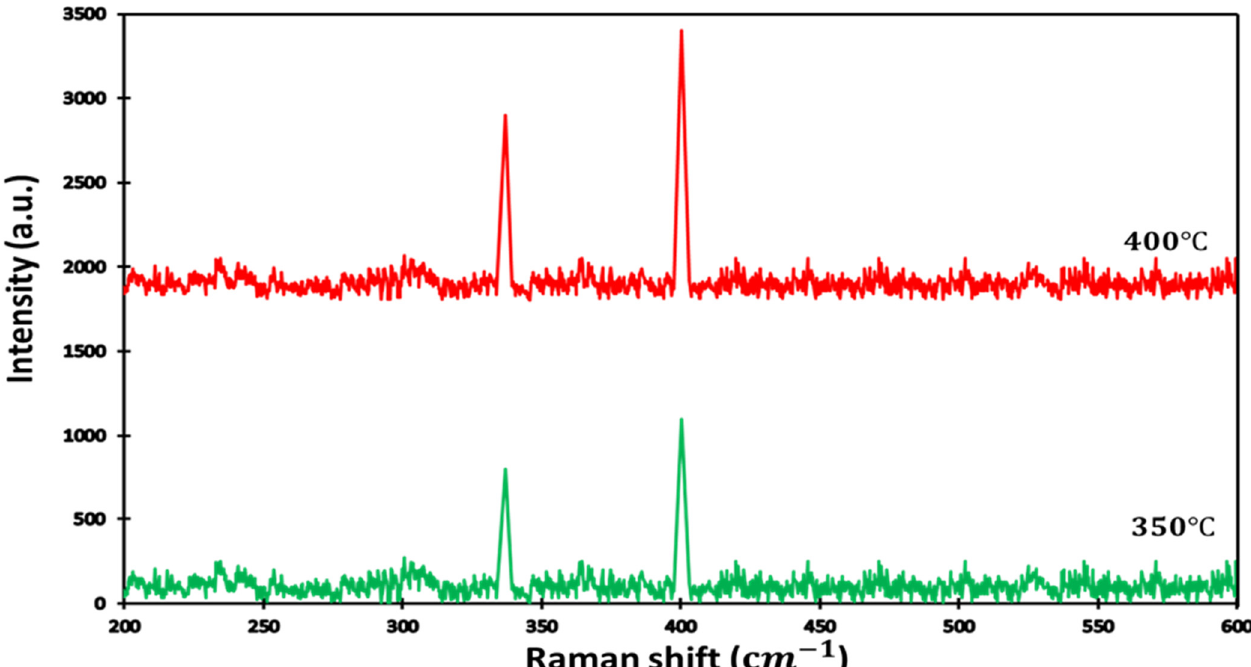
Figure 2. Raman spectra for thin film obtained after sulfurization for time = 14 h and at two sulfurization temperatures. Table 2. The intensity of the E low mode and the intensity ratio of (E low / E High ) modes of the FeS (cid:2870) sample at different temperatures.